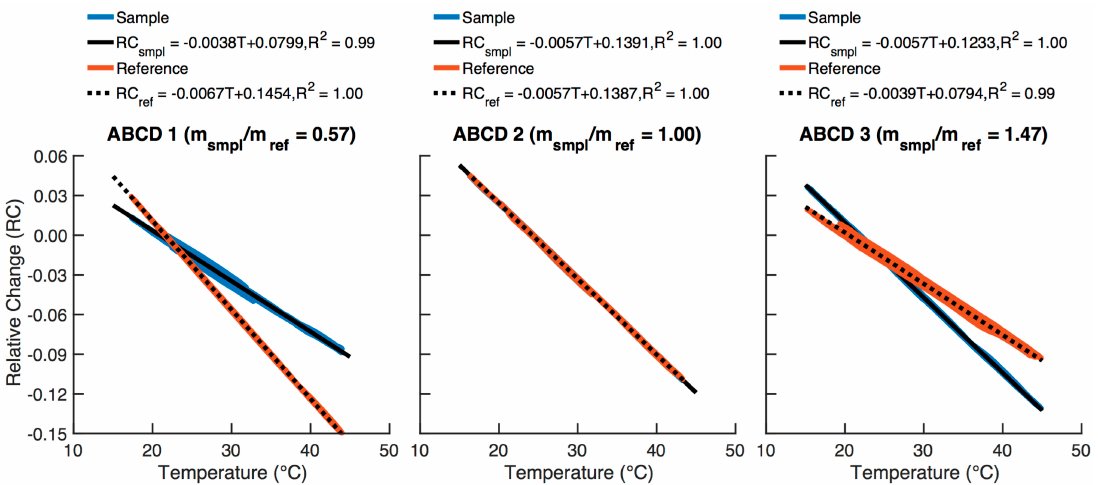
Figure 5. Relative change (RC) in the sample (blue) and reference (red) voltage outputs of three ABCD optical cells as a function of sample flow temperature, along with corresponding linear regression equations and coefficients of determination. The ratio of the sample to reference temperature sensitivities (m smpl /m ref ) of each optical cell is noted above each plot.